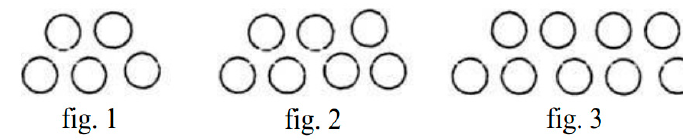
Figure 3. Pattern task [26]. Reproduced with permission of Vergel, R. of two superheroes, given as y = x + 4 [34], shown in Figure 4.